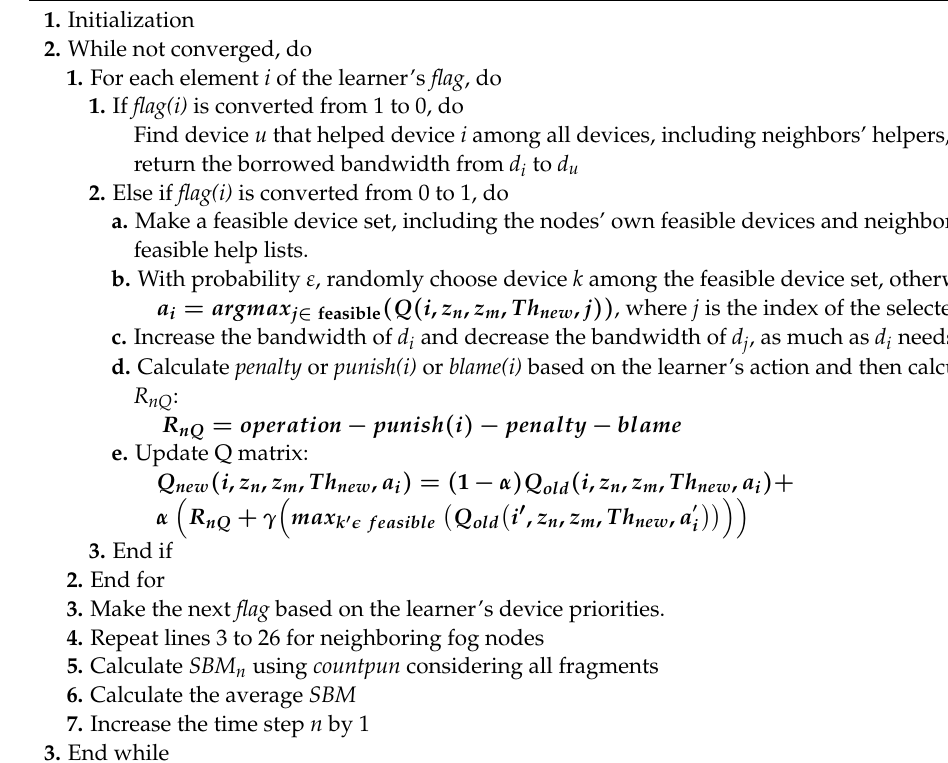
Algorithm 2: Second-level algorithm of the learning